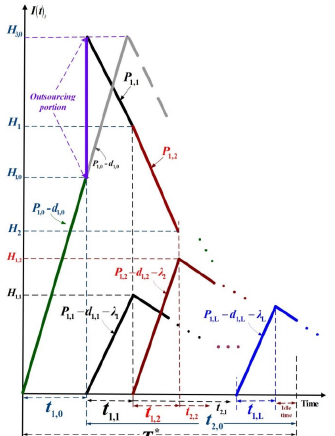
Fig. 1. Stock status of our proposed two-stage multiproduct batch production problem incorporates commonality, postponement, scrap, and external supplier compared with the same problem with no outsourcing option (in